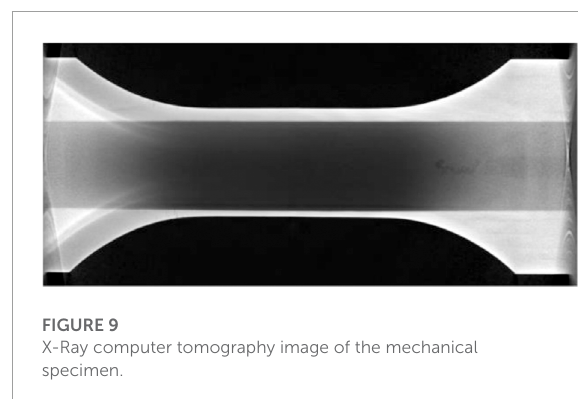
FIGURE 8 ROM-similarity for all instances of augmented data in ̃ D ( i ) . Augmented data related to digital twin 1 have indexes ranging from 1 to 100, and augmented data related to digital twin 2 have indexes ranging from 101 to 200. The dashed line is the constrain η ( i ) ( u ′) < α ϵ tol .